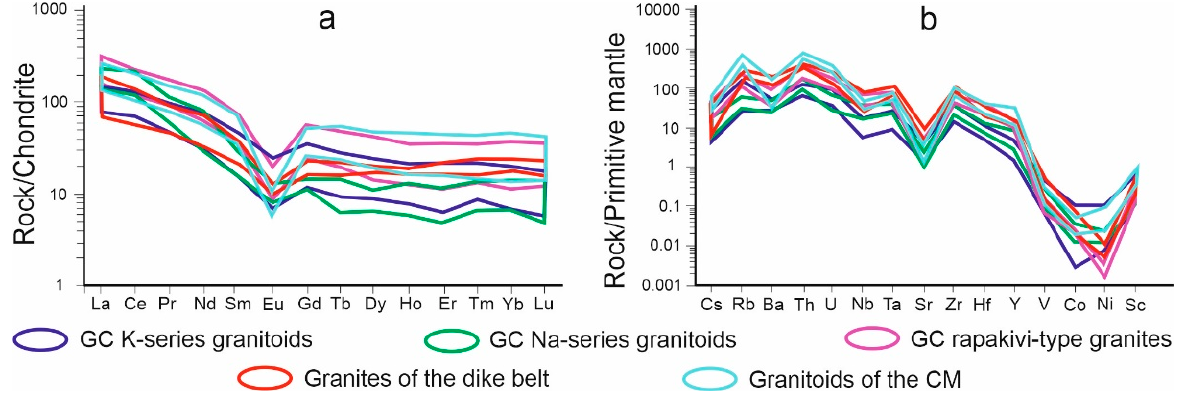
Figure 16. Chondrite-normalized REE patterns [98] ( a ) and primitive mantle-normalized spider- grams [99] ( b ) for felsic rock varieties of GC.